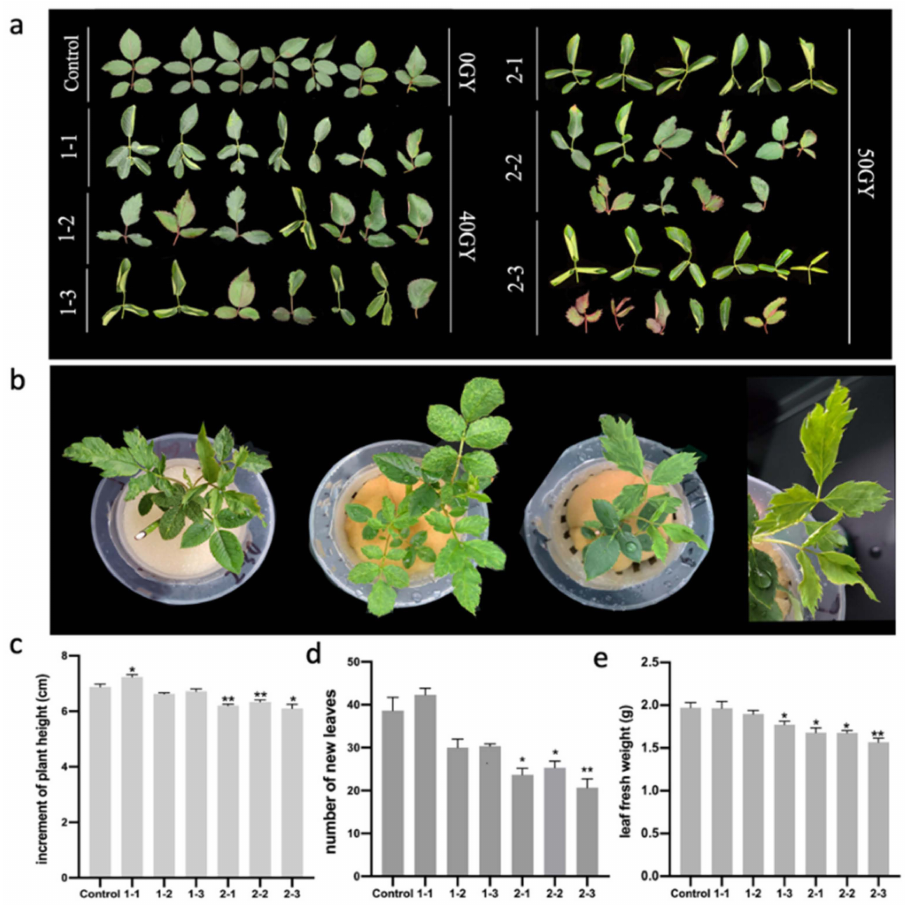
Figure 1. Effects of different doses of 60 Co γ -rays on the Rosa multiflora ‘Libellula’ leaf phenotype and growth record of the plants: ( a ) differences in the leaf phenotype between the control leaves and the leaves irradiated with 40 and 50 Gy; ( b ) deformed leaves of hydroponic R. multiflora ‘Libellula’ seedlings irradiated with 50 Gy; ( c ) Increment of plant height on the 30th day after irradiation; ( d ) the number of new leaves of the plants on the 30th day after irradiation; ( e ) the leaf fresh weight of the plants on the 30th day after irradiation. Asterisks indicate significant differences among treatments (* p < 0.05; ** p < 0.01). The vertical bars indicate the standard deviations of the means of three